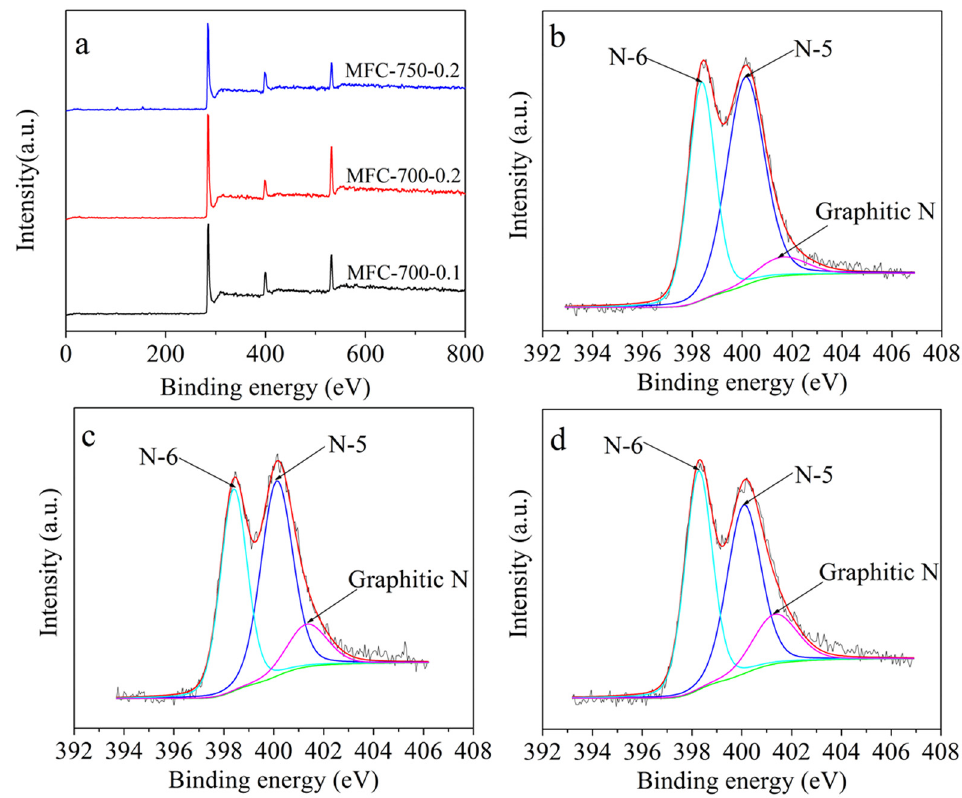
Figure 2. XPS survey ( a ) of selected adsorbents; XPS N 1s of ( b ) MFC-700-0.1, ( c ) MFC-700-0.2, and ( d ) MFC-750-0.2. In ( b , c ), the black line is the original data and the red line is the fitting curve, the green line is the background. Table 1. Porous textural, elemental compositions, and CO 2 uptakes of adsorbents derived from melamine formaldehyde resin under different conditions.